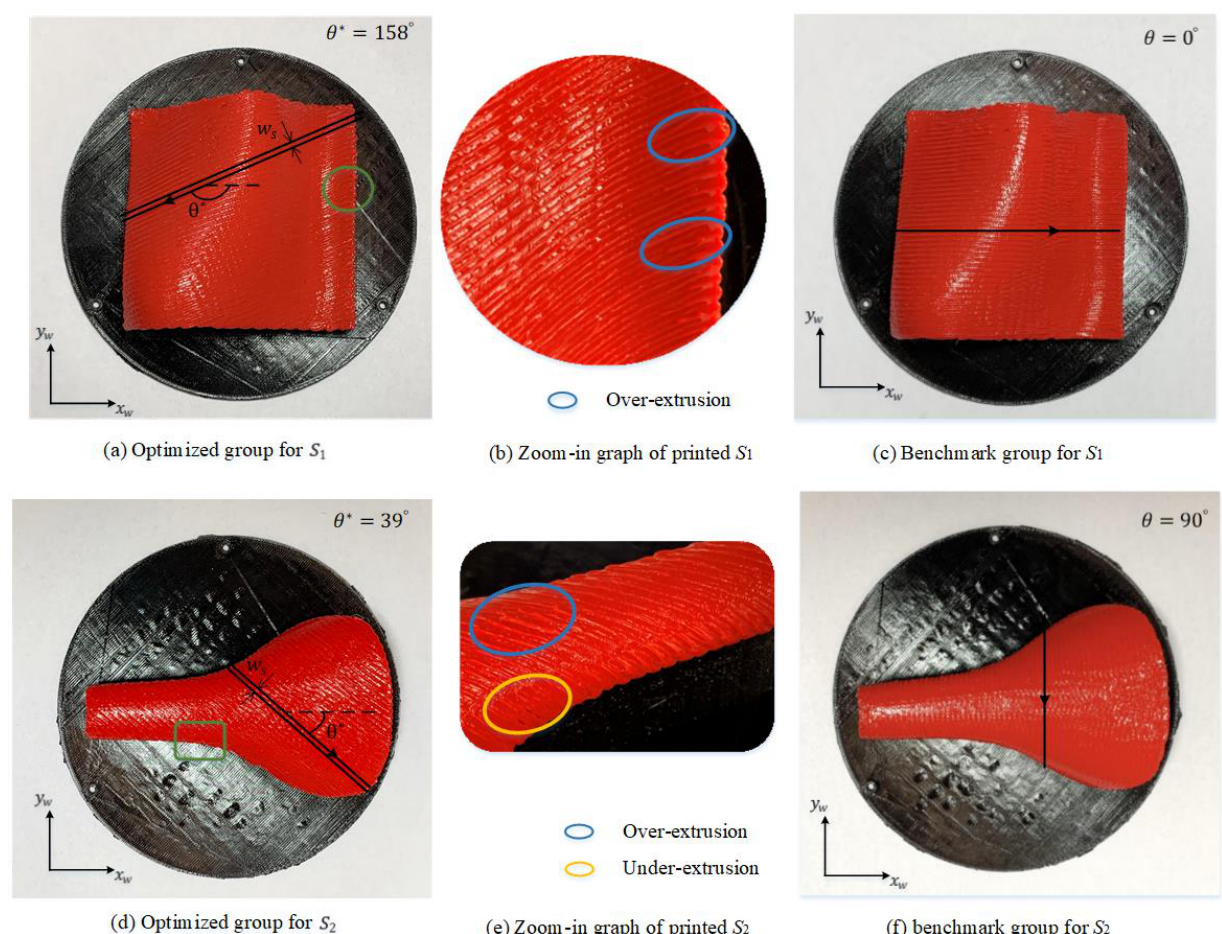
Figure 12. The printed parts by the optimized and non-optimized printing paths.